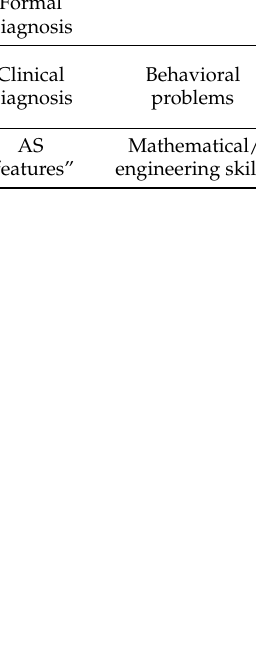
Table 2. Segregation analysis of 18 variants obtained from the filtering and prioritizing process. RefSeq Gene and HGVS Position † Nomenclature